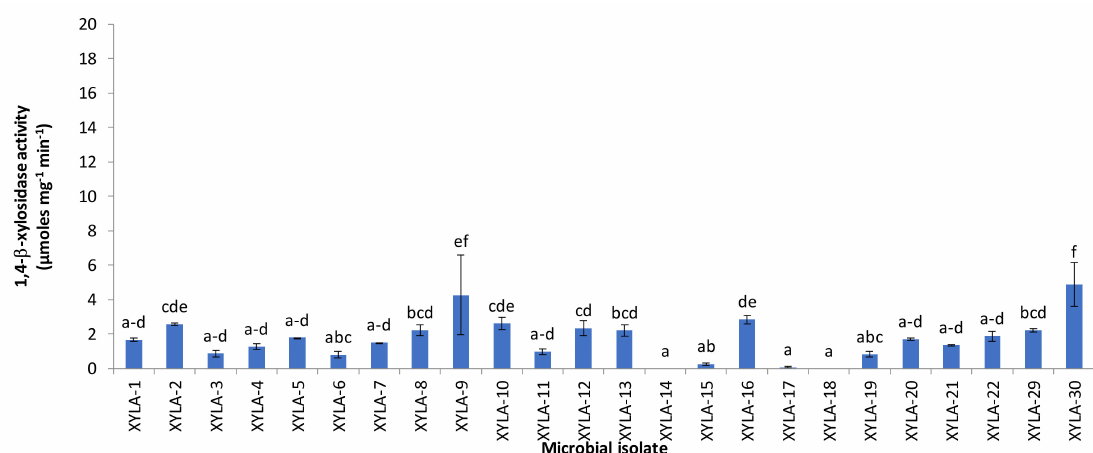
Figure 2. 1,4- β -xylosidase activities (extracellular fraction) of the microbial strains isolated from orange juice processing waste.